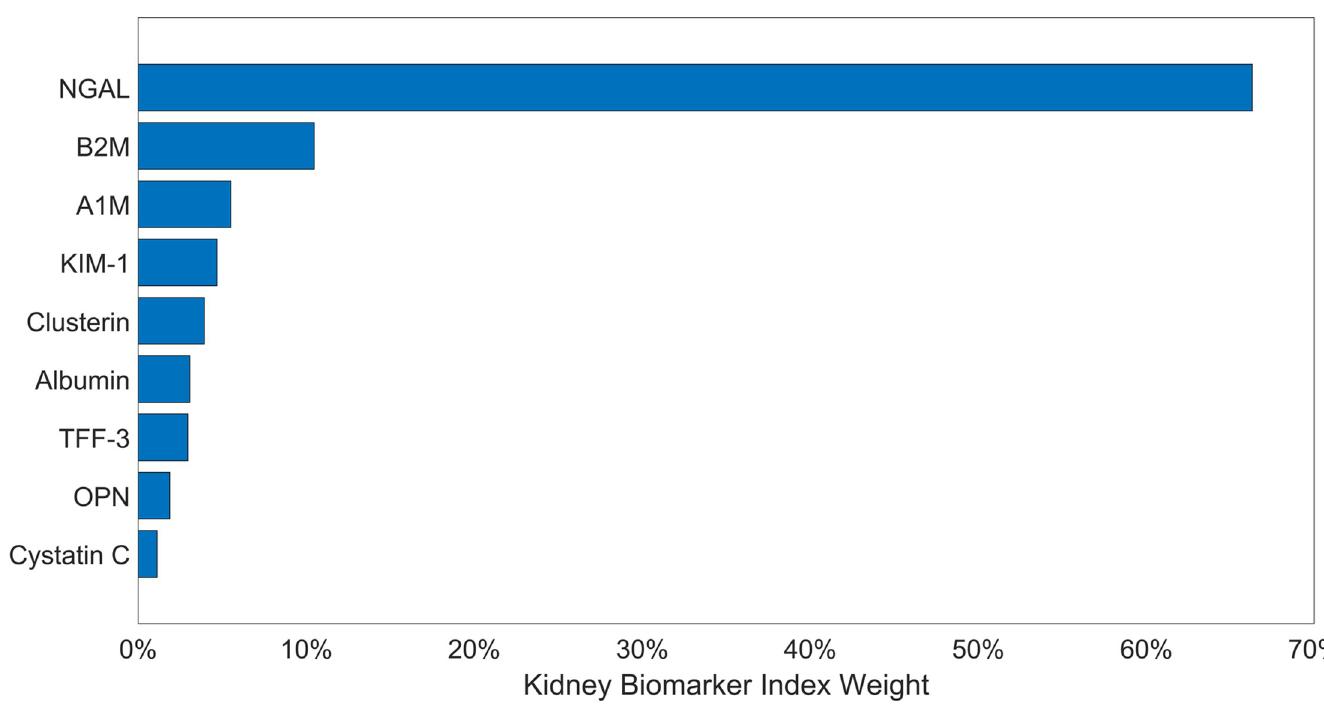
Fig 4. Weights of proteins contributing to the kidney biomarker index estimated for birth weight. Larger weights indicate greater contribution of the protein to the index.